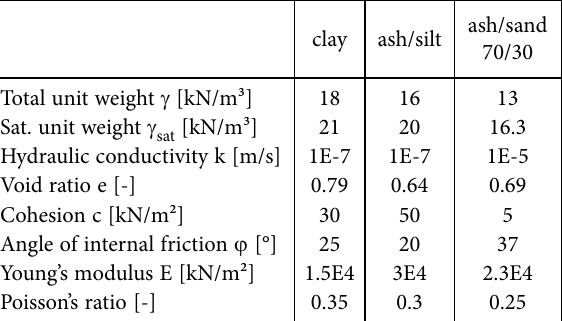
Fig. 2. Angle of internal friction and cohesion of the different sand